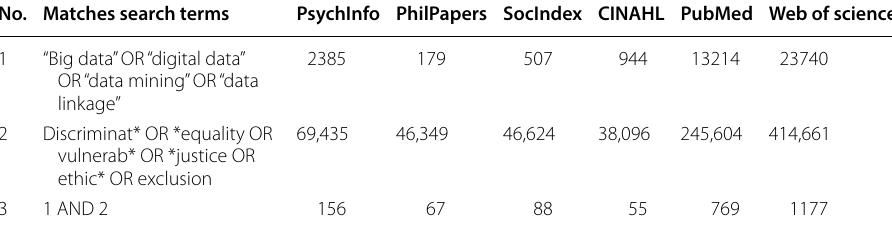
No. Matches search